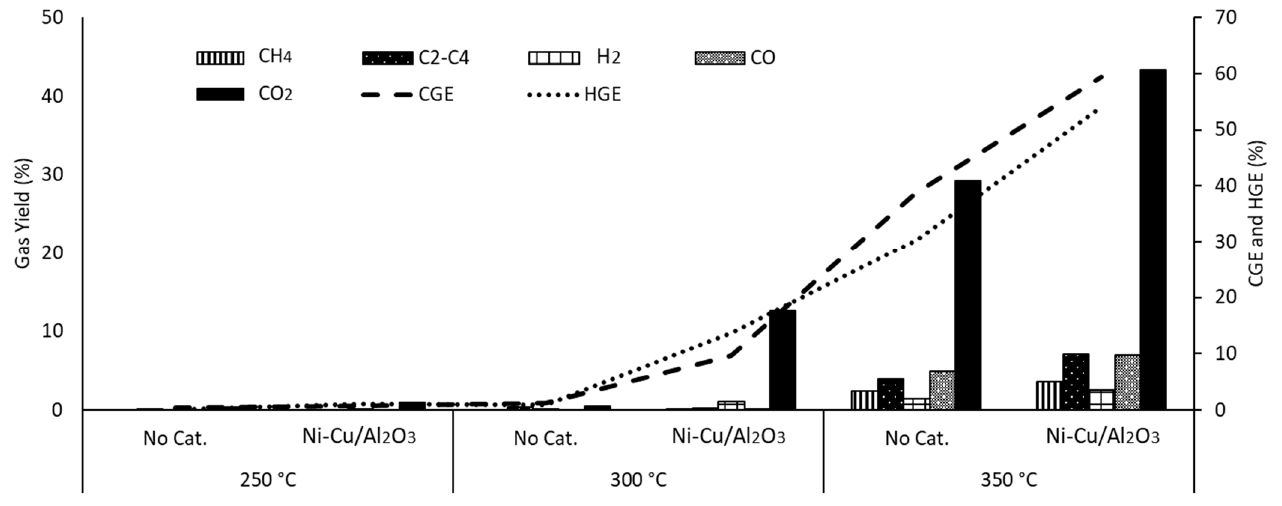
Figure 4. Effect of temperature on catalytic reforming of glycerol without and with the Ni ‐ Cu/Al 2 O 3 catalyst.